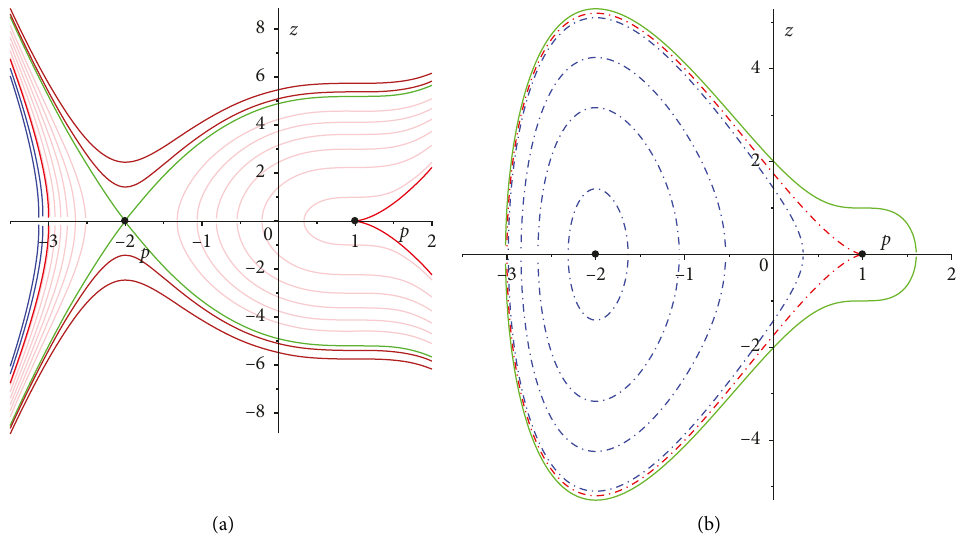
Figure 3: Phase portrait for the Hamilton system (43) for